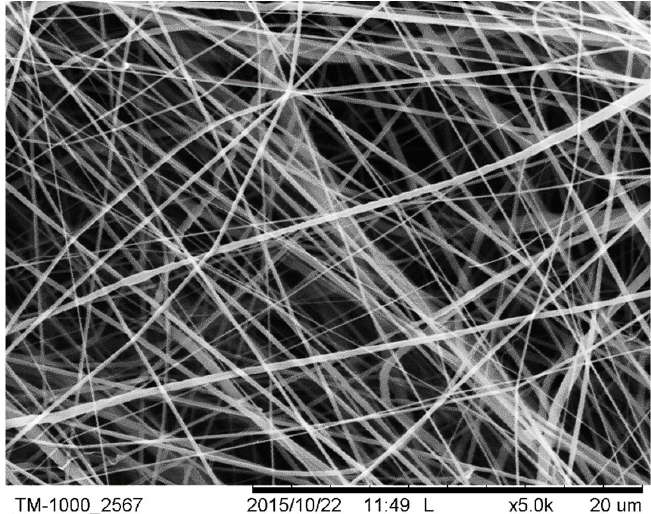
Figure 1. SEM image of polycaprolactone (PCL)–Collagen–levofloxacin (LEVO) fibres at 20 µ m scale.